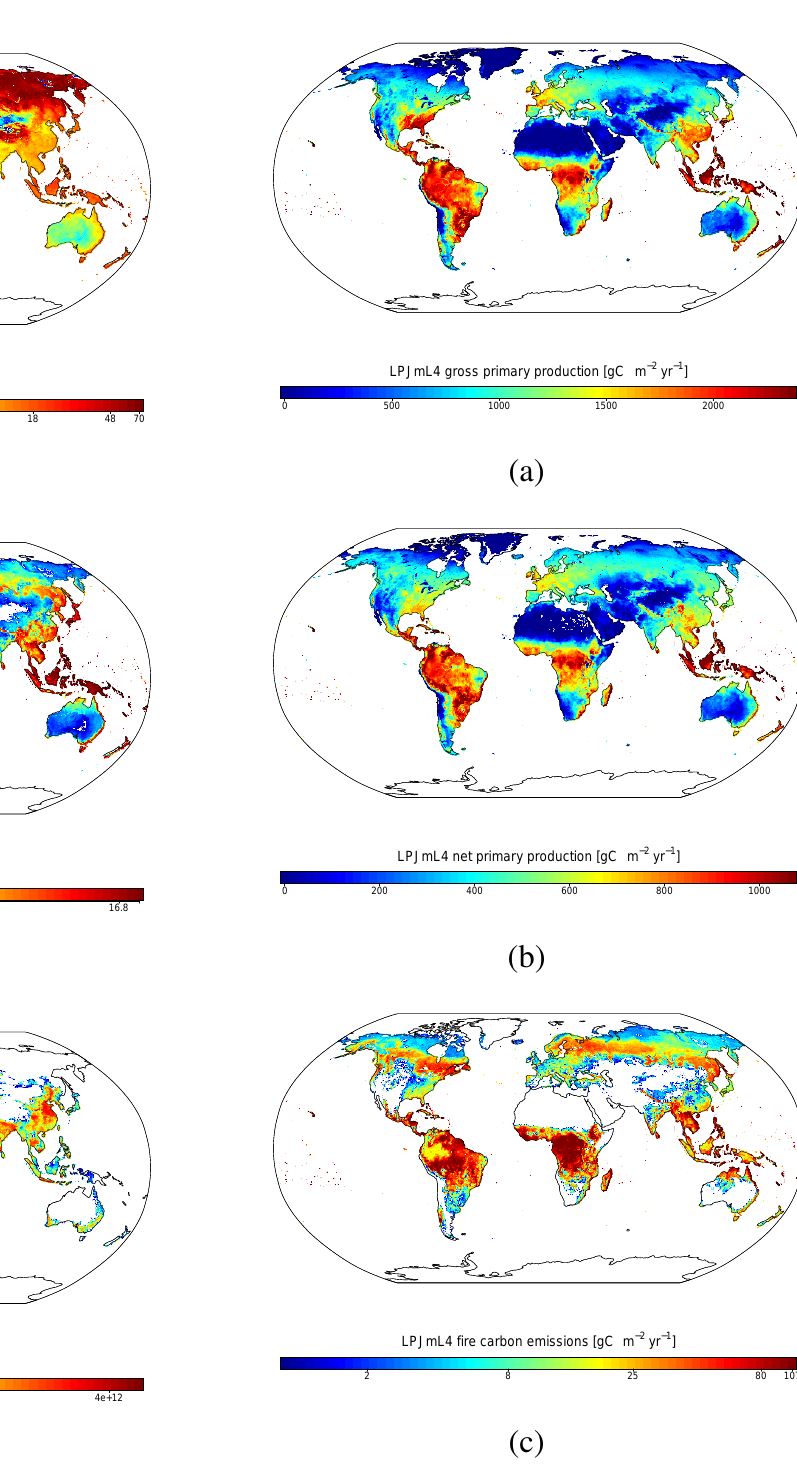
Figure 3. Soil (a) and vegetation (b) carbon pool and cumulative crop production (c) computed by LPJmL4 as an average of the time period 1996–2005. Note: values are plotted on a logarithmic scale.